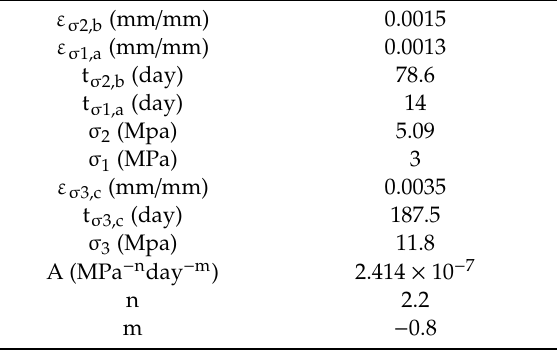
Table 1 represents: a summary to the experimental results obtained from the quasi-static testing, the applied levels of stress (flexural) to each group of WPC and the stress level applied to each WPC specimen in each group, the values of inserted in Equations (2) and (3), and the computed parameters. Figure 3 shows a typical relationship between the experimental creep strain versus time of three WPC specimens at three di ff erent stress levels (7% Fb, 14% Fb, and 29% Fb) and the selected lines (a, b, and c) on these relationships used to compute the Norton-Bailey parameters [19,20]. The mechanical